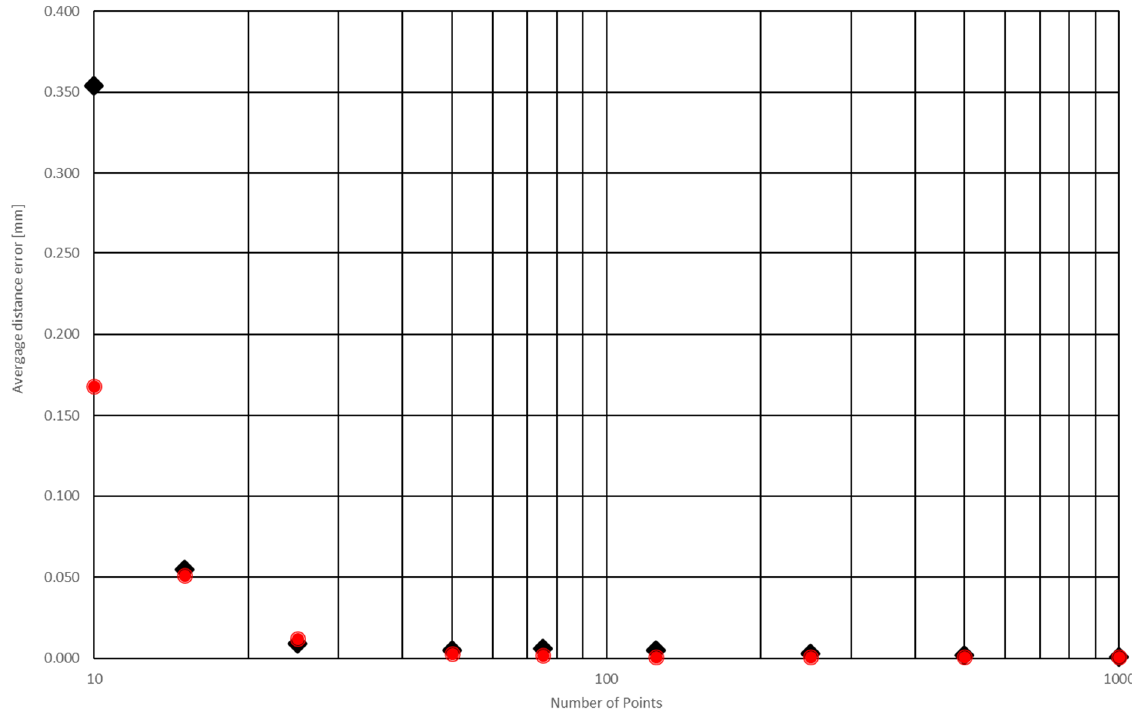
Figure 8. Average distance error between 10 and 1000 control points (black, turbine guide vane; red, turbine blade).